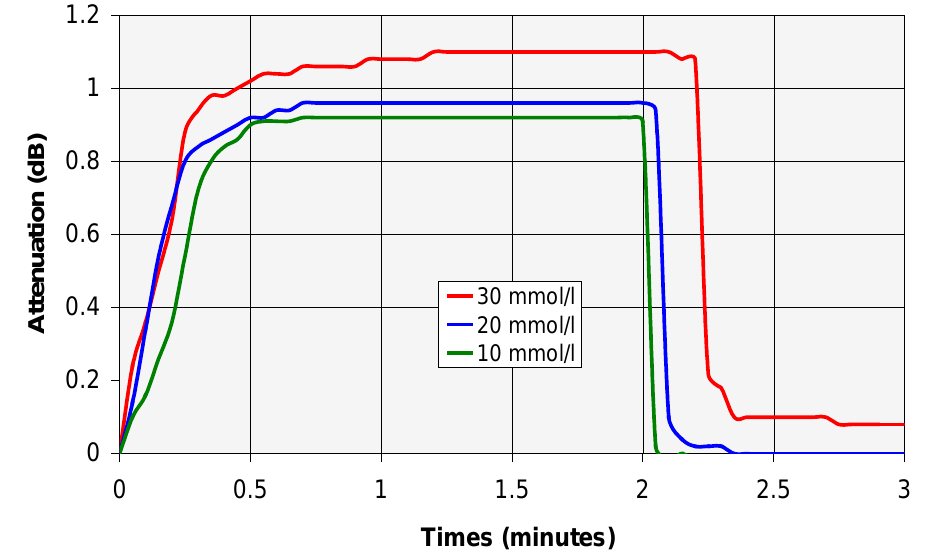
Figure 10. Response of the sensor when exposed to three different concentrations of